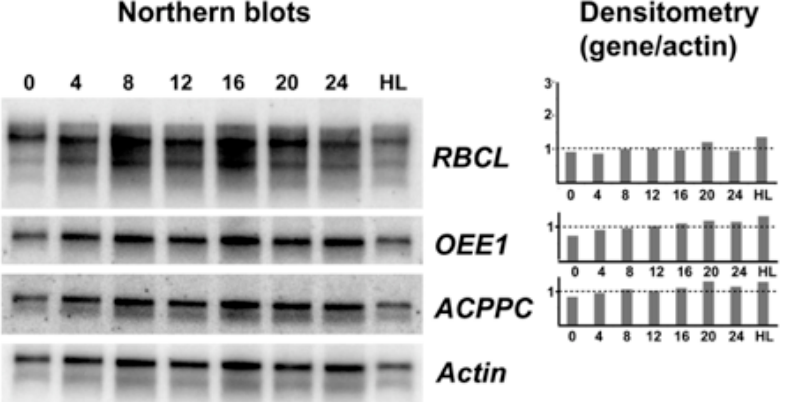
Figure 2. Northern blot analysis of three potentially light regulated transcripts. A representative sample of northern blots ( n = 4) using either an rbcL , an oee1 , an acppc , or an Actin cDNA as a probe. RNA was prepared from samples taken every four hours from cells grown under a normal 12:12 LD cycle as well as from cells grown under high light (note that LD 0 and LD 24 should be identical). At right, densitometric scans for the top three probes are shown relative to the Actin signal.